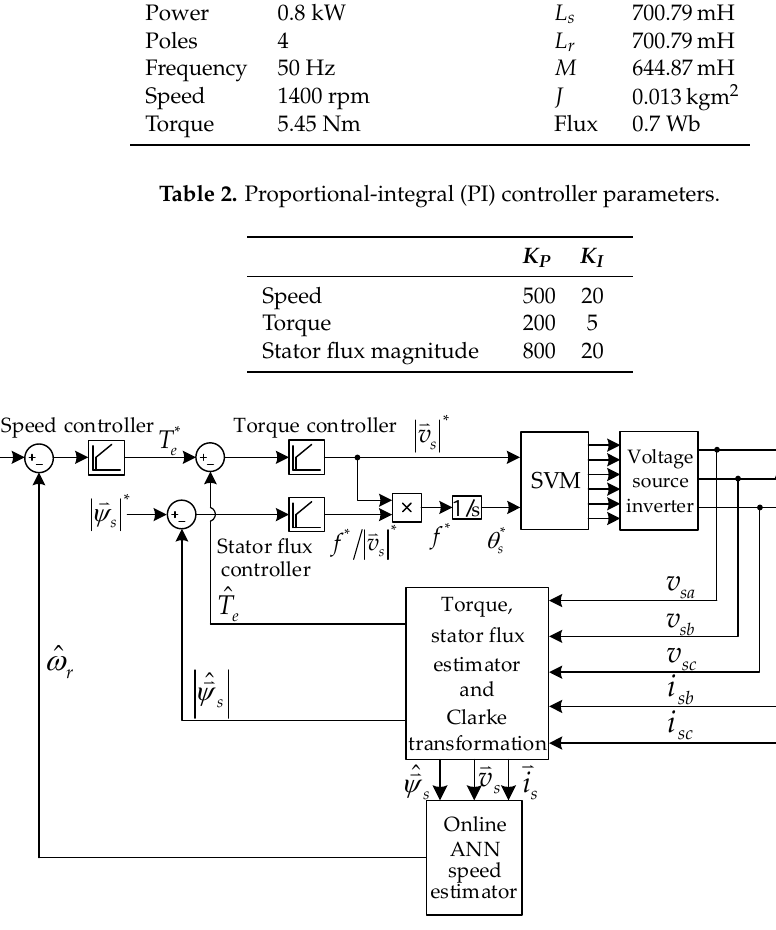
Table 1. Parameters of a three-phase induction motor.